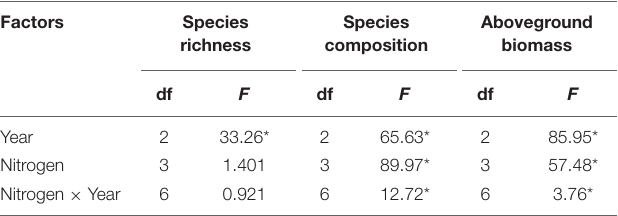
TABLE 1 | Two-way ANOVA for the effects of year and N-addition rate on species richness, species composition, and total aboveground biomass. Factors Species Species Aboveground richness composition biomass